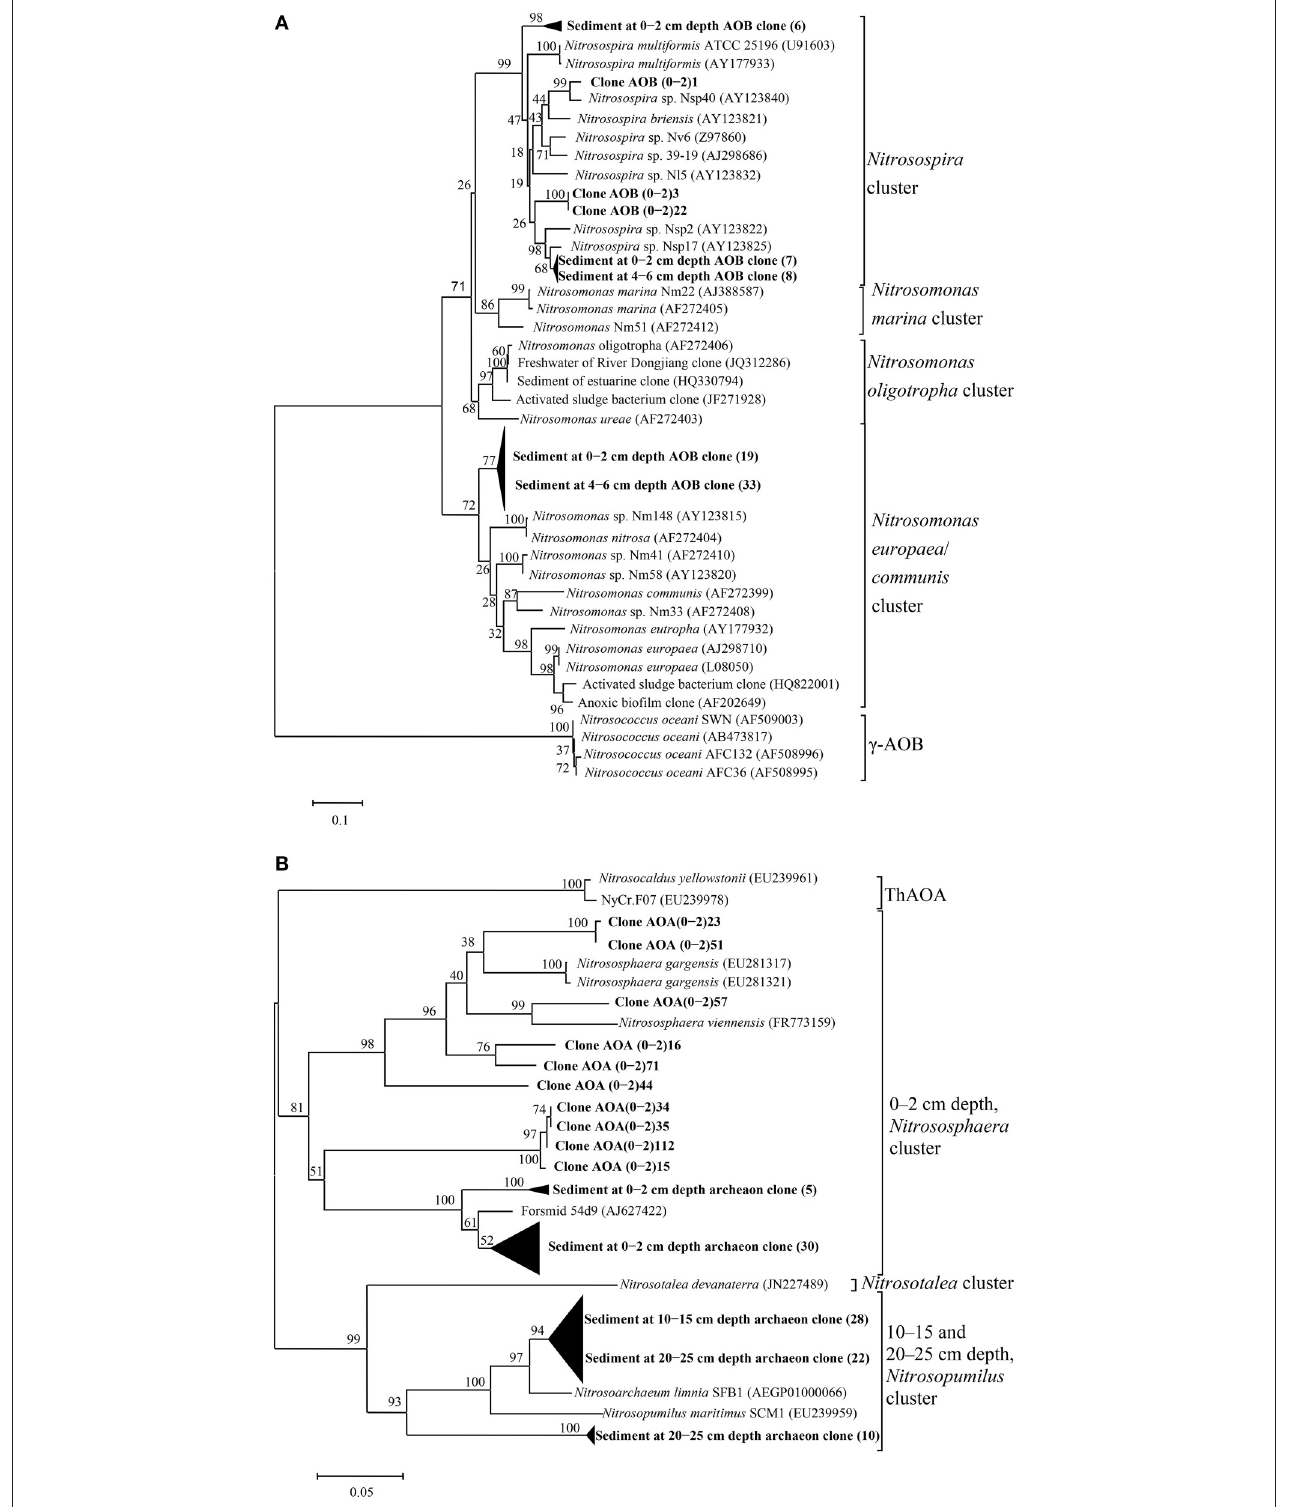
FIGURE 6 | Phylogenetic tree of AOB (A) and AOA (B) based on partial amoA gene sequence (472 bp for AOB and 597 bp for AOA) from the aquaculture pond sediment and some related sequences from GenBank reconstructed via the neighbor-joining method by fixing the Kimura 2-parameter evolution model with a bootstrap level of 1000 replications in MEGA 5.0. The numbers close to the nodes represent the bootstrap values